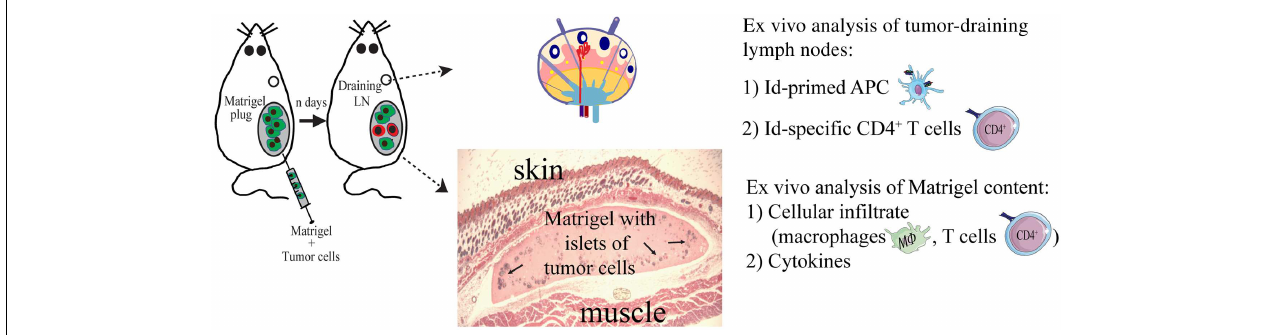
forms a plug containing the tumor cells. At various time points after injection ( n days), the Matrigel plug and tumor-draining lymph nodes are dissected out and analyzed ex vivo for cellular content, function of cells, and cytokines (34, 36, 39,